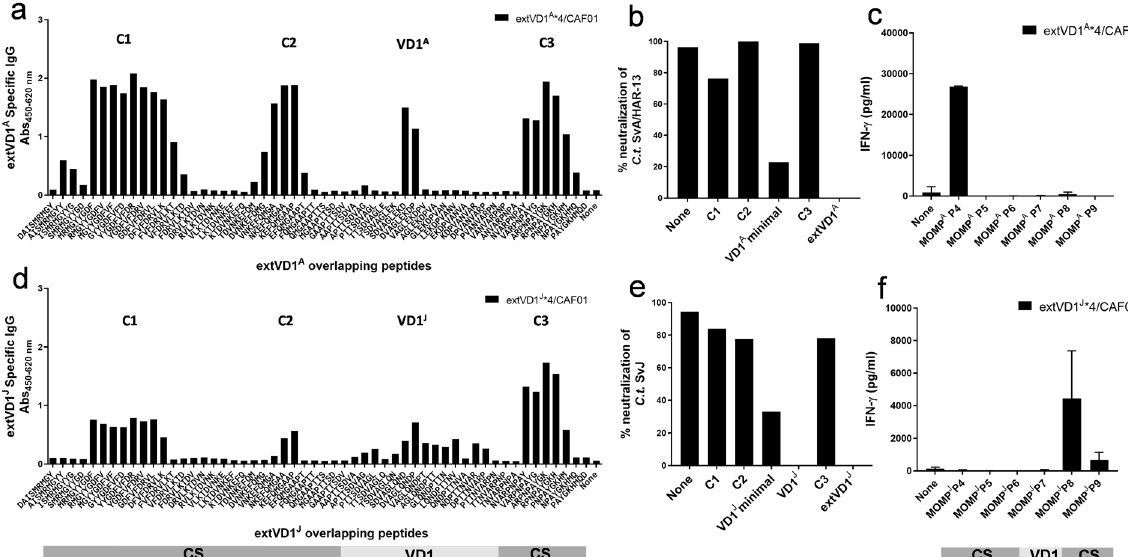
Fig. 2 Fine speci fi city of antibody and T-cell responses after extVD1 A *4 and extVD1 J *4 vaccination. A/J mice were immunized 3 times s.c. with either 10 µg of extVD1 A *4/CAF01 or extVD1 J *4/CAF01. Three weeks after the last vaccination, sera from immunized mice were pooled ( n = 5 – 6), diluted 1:200, and the fi ne speci fi city of the IgG antibody responses was studied using a panel of biotinylated overlapping peptides (9-mers with 8 amino acid overlap) representing the extVD1 regions from SvA ( a ) and SvJ ( d ). Each bar represents the mean OD value of two determinations. Competitive peptide inhibition of in vitro neutralization of C.t . SvA and SvJ with peptides representing the four identi fi ed B-cell epitope regions in extVD1 A ( b ) and extVD1 J ( e ), respectively. Spleen cells were used to investigate the speci fi c IFN- γ responses using panels of 20 – 22-mer peptides with 10 amino acid overlap (Supplementary Table 2) spanning extVD1 A ( c ) and extVD1 J ( f ) regions. Cells from 6 mice/group were pooled and tested in triplicates. Each bar represents mean ± SEM. The individual experiment was repeated 2 – 3 times with similar